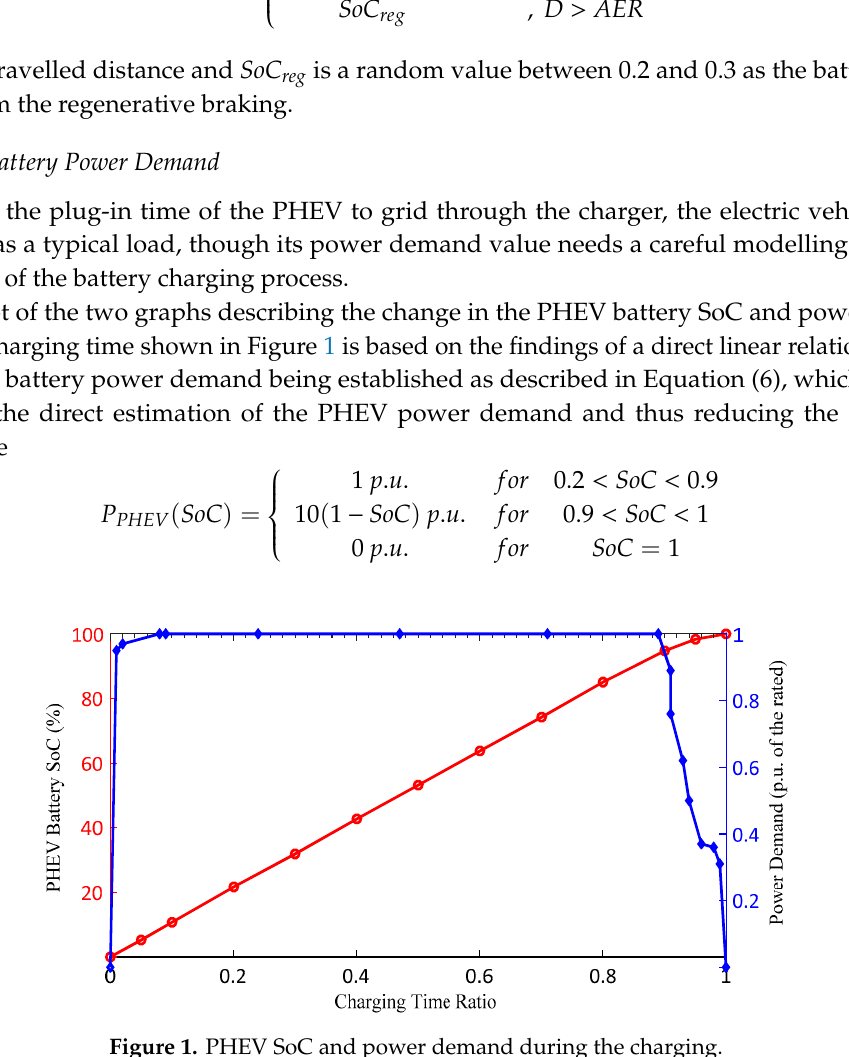
Figure 1. PHEV SoC and power demand during the charging.